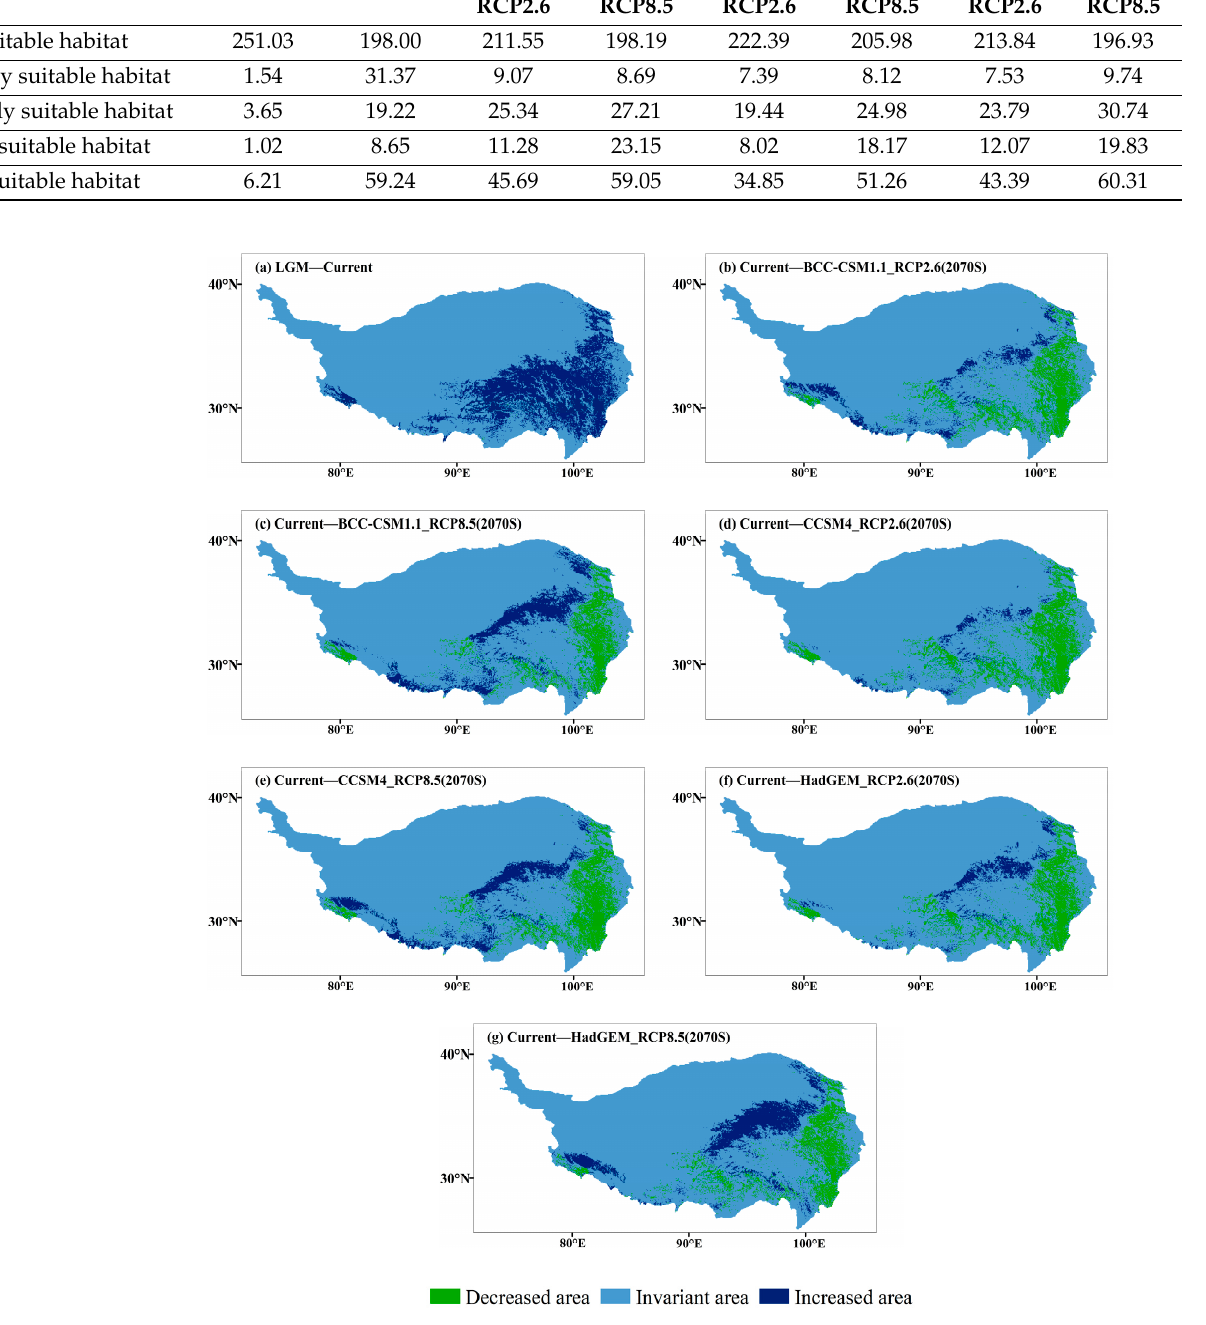
Figure 6. Changes of suitable habitat J. tibetica under different climate scenarios. ( a ) Differences between current and LGM modelled suitable habitat, including areas decreased and increased since the LGM; ( b ) Differences between BCC-CSM1.1 (RCP2.6) and current modelled suitable habitat; ( c ) Differences between BCC-CSM1.1 (RCP8.5) and current modelled suitable habitat; ( d ) Differences between CCSM4 (RCP2.6) and current modelled suitable habitat; ( e ) Differences between CCSM4 (RCP8.5) and current modelled suitable habitat; ( f ) Differences between HadGEM2-ES (RCP2.6) and current modelled suitable habitat; ( g ) Differences between HadGEM2-ES (RCP8.5) and current modelled suitable habitat.